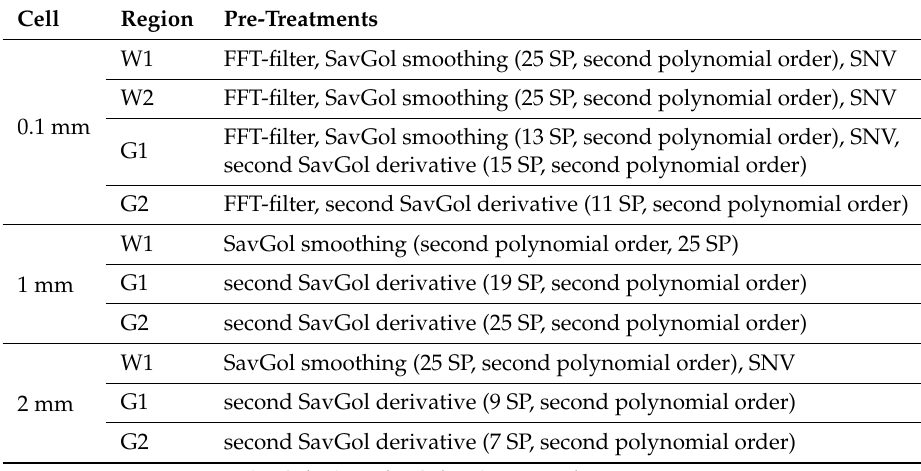
Table 1. Details of spectral pre-treatments applied to each spectral